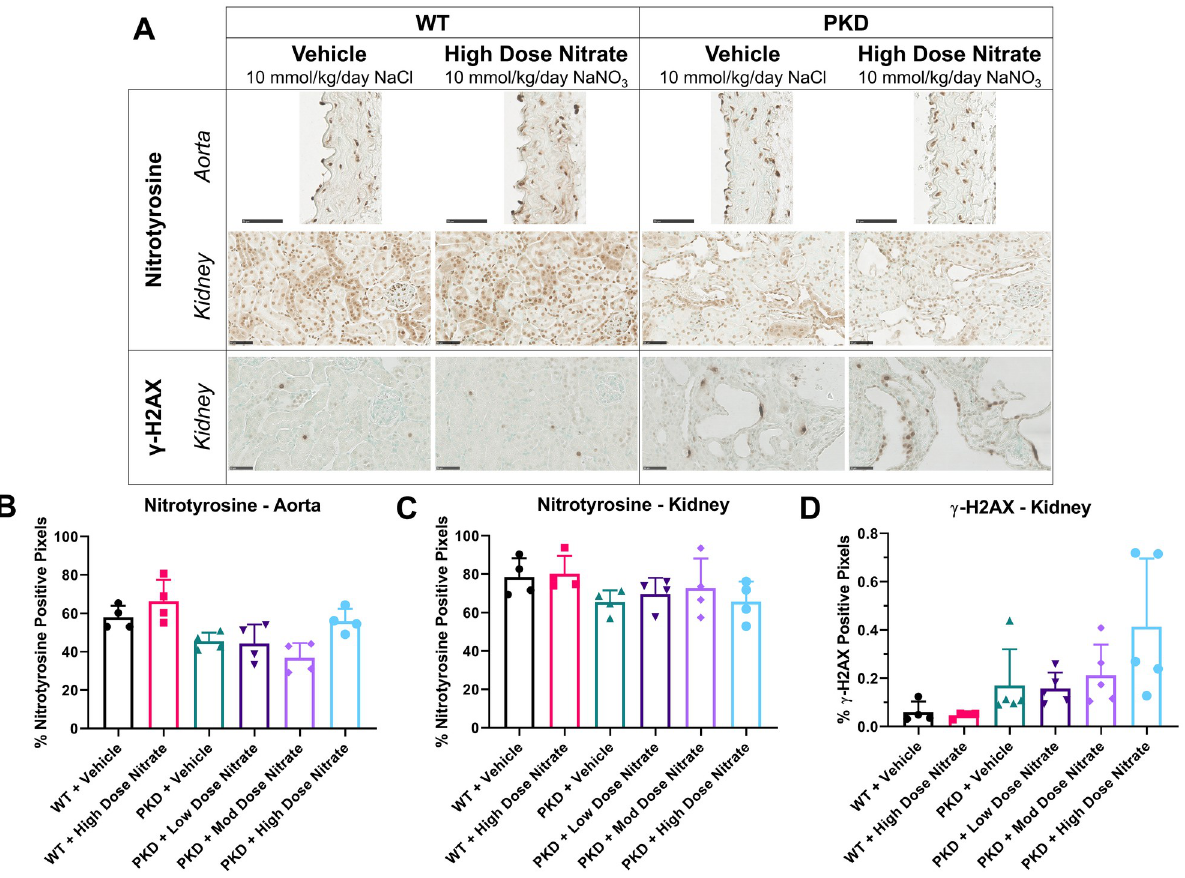
Fig 6. Immunohistochemistry for nitrotyrosine and gamma ( γ )-H2AX in the aorta and kidney of wild-type (WT) and Pkd1 RC/RC (PKD) mice treated with sodium chloride (vehicle) or sodium nitrate (low, 0.1 mmol/kg/day; moderate, 1 mmol/kg/day; high dose, 10 mmol/kg/day) for 8 months. (A) Representative images of nitrotyrosine and γ -H2AX positive staining in the aorta and kidney; (B) Quantification of nitrotyrosine positive staining in the aorta; (C) Quantification of nitrotyrosine positive staining in the kidney; (D) Quantification of γ -H2AX positive staining in the kidney. Data presented as means ± SD (n = 4–6 per